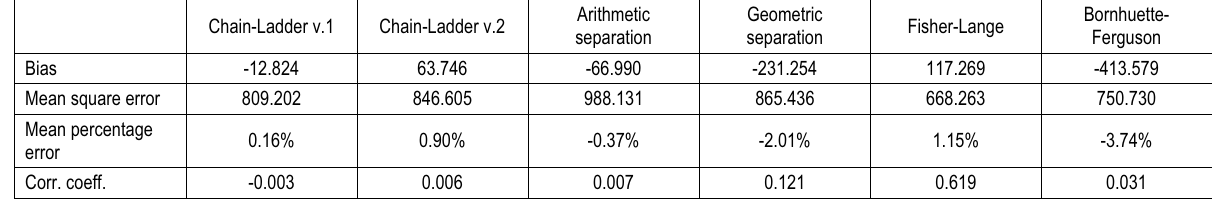
Table 5. Method of backward calculated random development factors